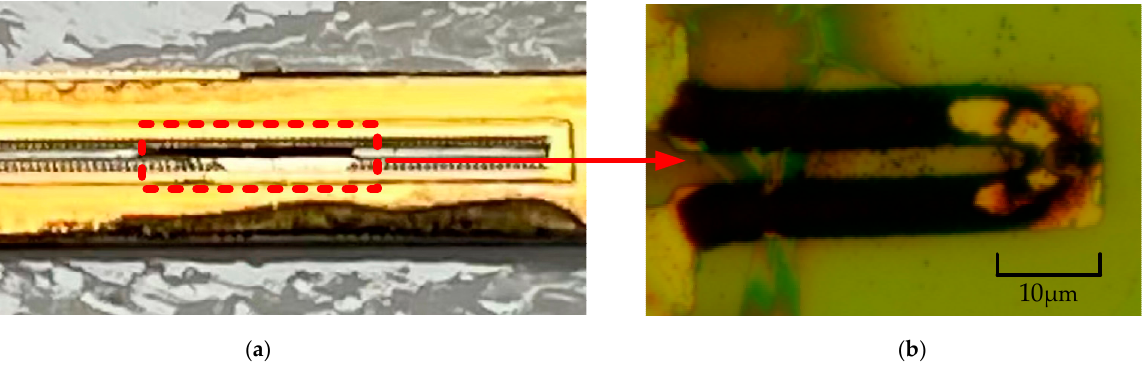
Figure 16. When the driving voltage was 14 V, the inkjet chip is burned. ( a ) Under the microscope, we used tweezers to scrape the SU-8 photoresist off the surface of the chip, and the nozzle and chamber were removed to facilitate the observation of heating resistors. ( b ) The heating resistors were burnt out due to the excessive voltage.